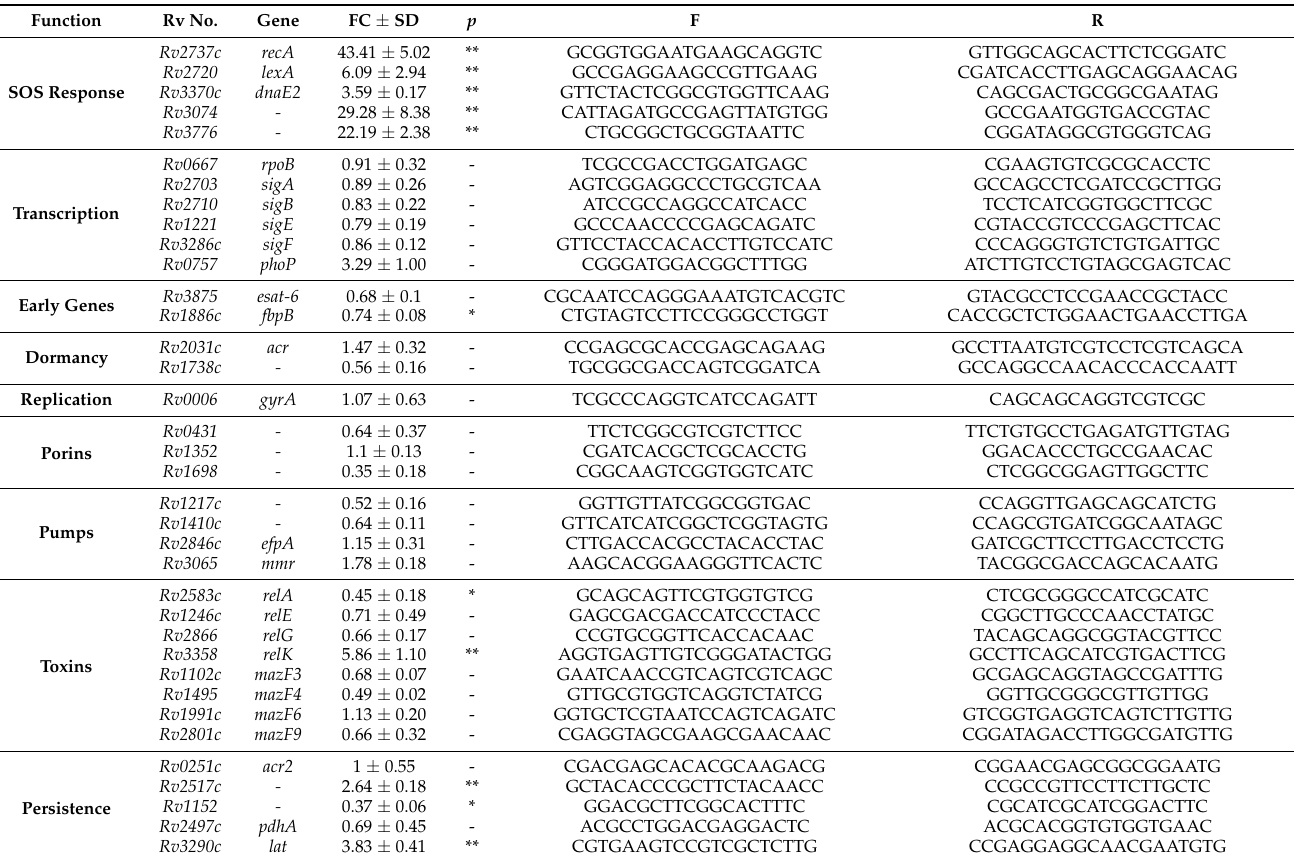
Table 2. mRNA fold-changes (FC) and standard deviations (SDs) determined by qRT-PCR for each indicated gene in aerobic Mtb H37Rv cells treated with 2 × MIC (0.25 µ g/mL) of MX for 16 h, compared to control cells grown in the absence of the drug F and R: forward and reverse primers, respectively (*), p < 0.02; (**), p < 0.002; (-), not significant. The SOS response genes refer to data shown in Figure